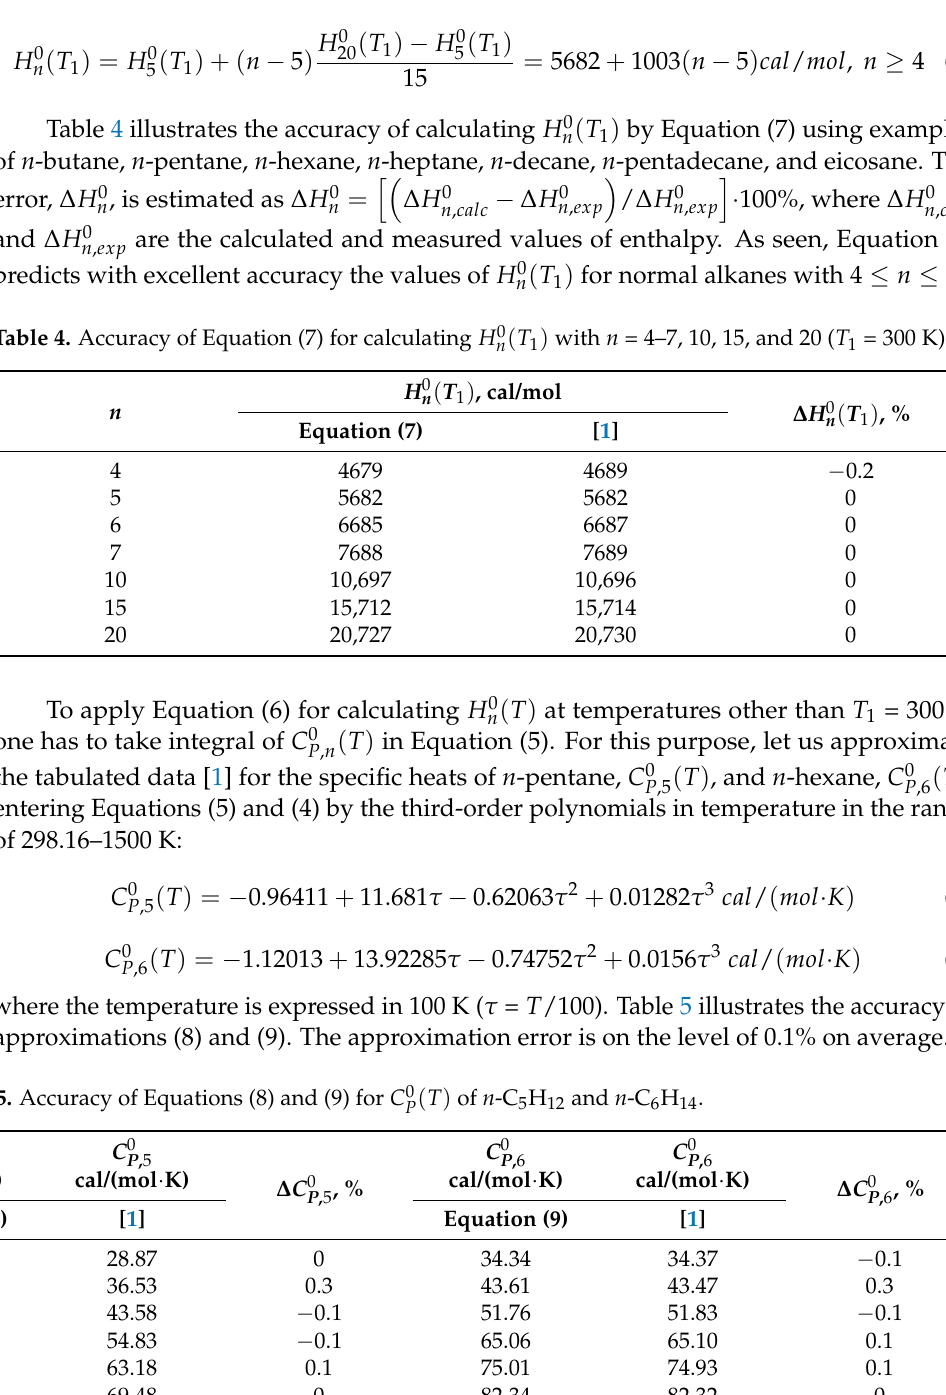
) , on n can be ( T 1 n